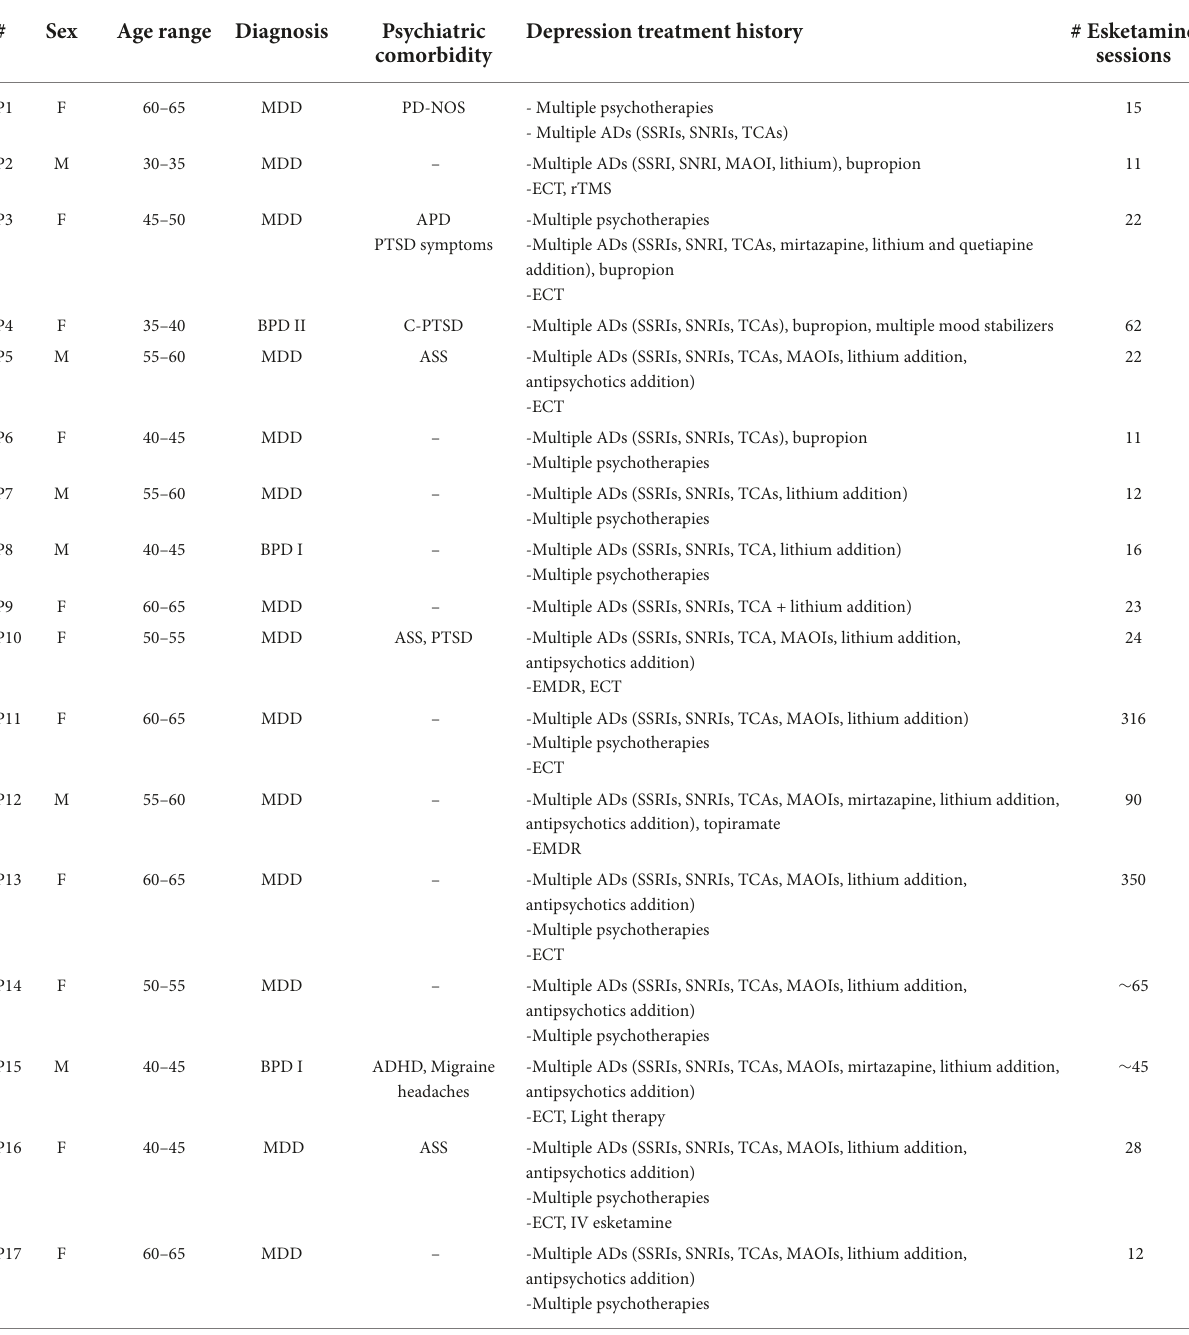
TABLE 1 Respondent